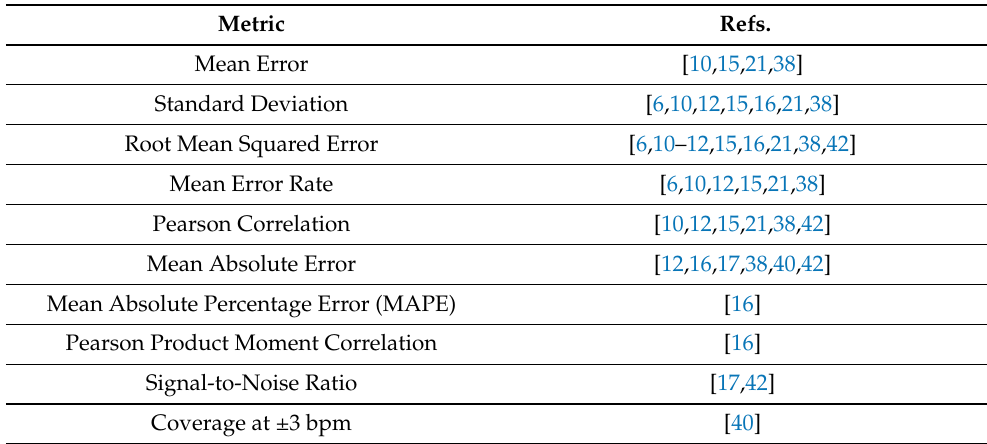
Table 4. Table with the metrics used by the articles. Metric